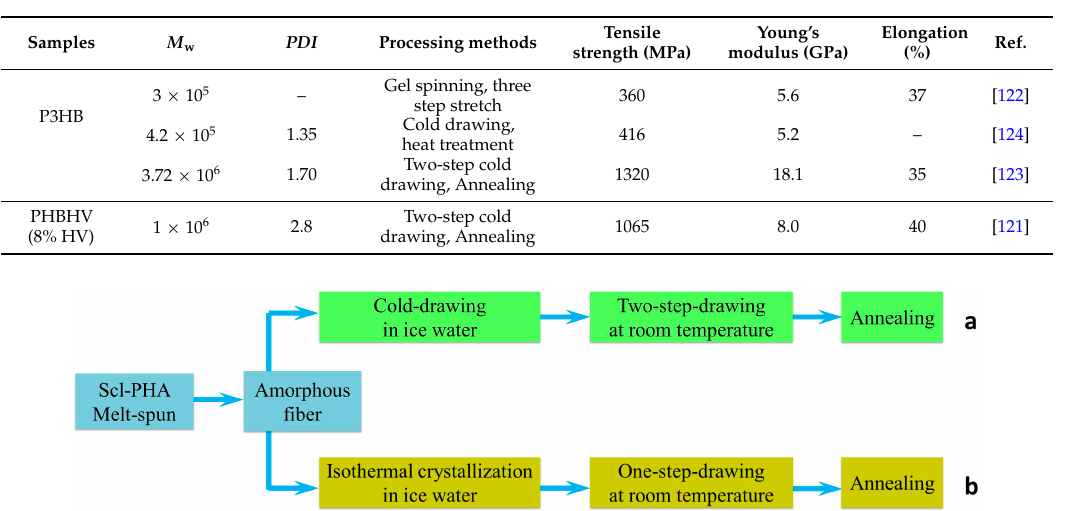
Table 2. Mechanical properties of scl-PHA fibers/ films.